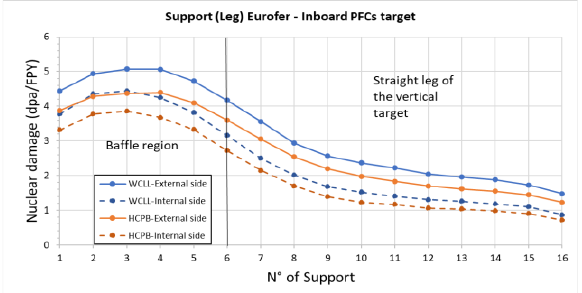
Figure 46. Inner poloidal profiles of the nuclear damage (dpa/FPY) on PFC-CB supports made of Eurofer, comparing the values on the external and the innermost target sides, both for WCLL and HCPB blanket case.